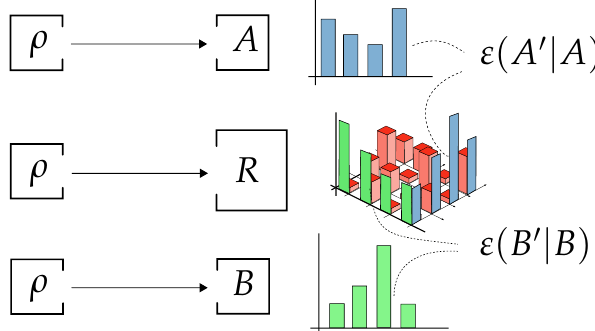
Figure 1. Basic setup of measurement uncertainty relations. The approximate joint measurement R is shown in the middle, with its array of output probabilities. The marginals A (cid:48) and B (cid:48) of this array are compared to the output probabilities of the reference observables A and B , shown at the top and at the bottom. The uncertainties ε ( A (cid:48) | A ) and ε ( B (cid:48) | B ) are quantitative measures for the difference between these